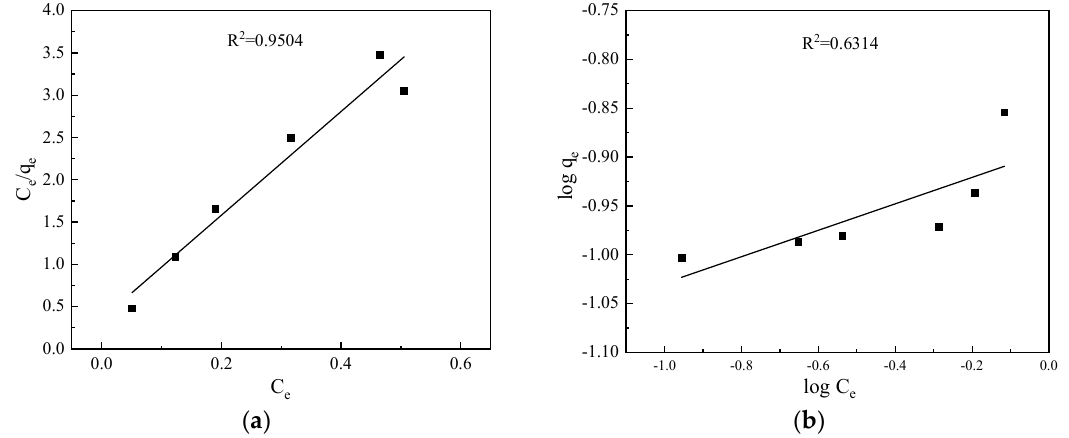
Figure 2. Adsorption isotherms for ammonium nitrogen adsorption: ( a ) Langmuir; ( b ) Freundlich.